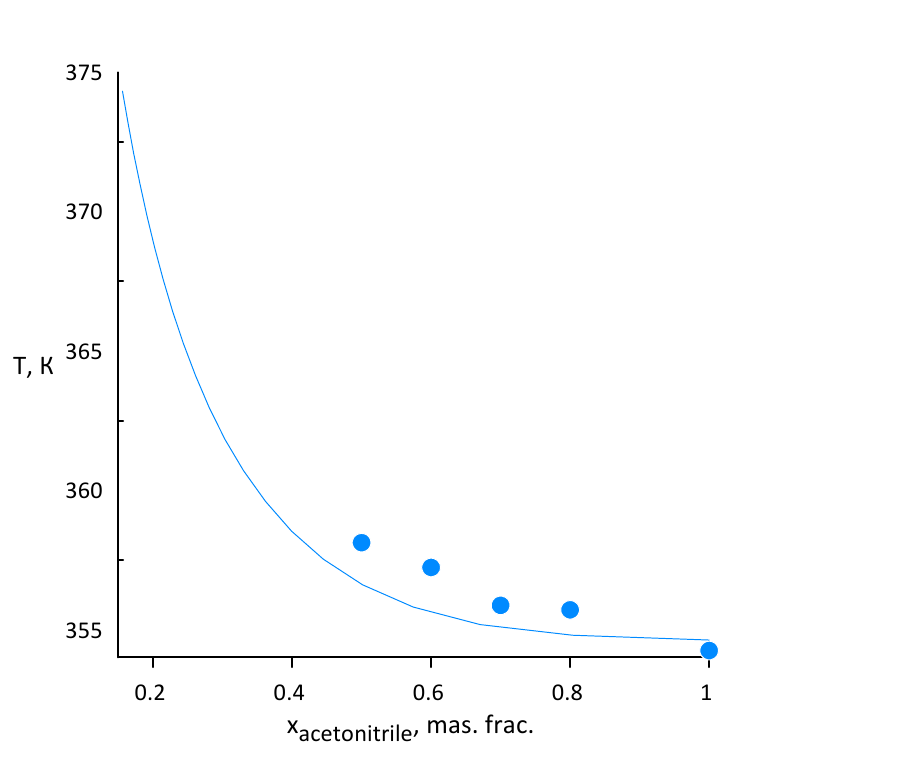
Figure 8. Boiling temperature of the binary mixture acetonitrile-AEBA–TEG at atmospheric pressure. Geometric figures—experimental data, line—calculation according to the UNIFAC model (Table 2).